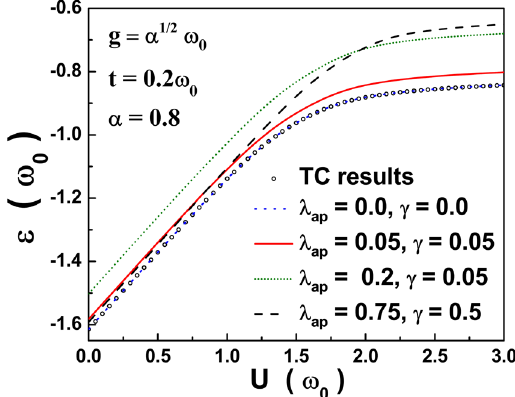
Figure 1. GS energy ( ε ) vs. on-site e-e correlation strength U .